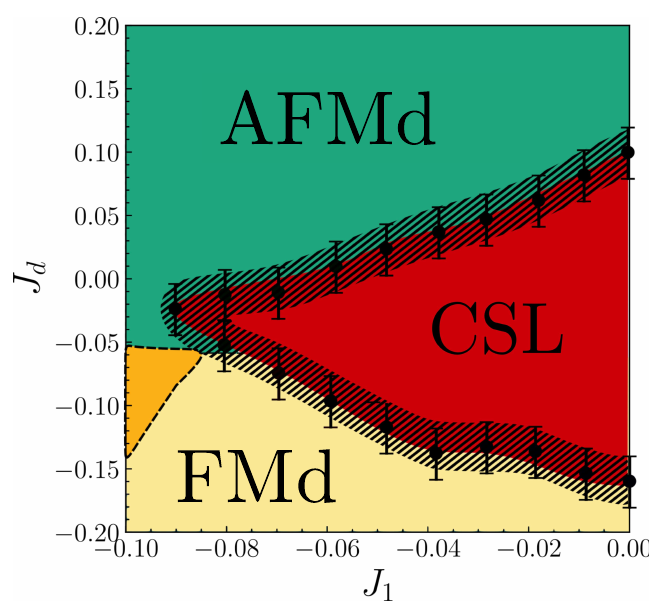
Figure 9: Phase diagram of the model in Eq. (1) on the kagome lattice obtained via VMC for J χ = 1 and S = 1 / 2. We focus on the region around the chiral spin liquid (CSL) phase. The classical representation of the magnetically ordered phases is shown in Fig.